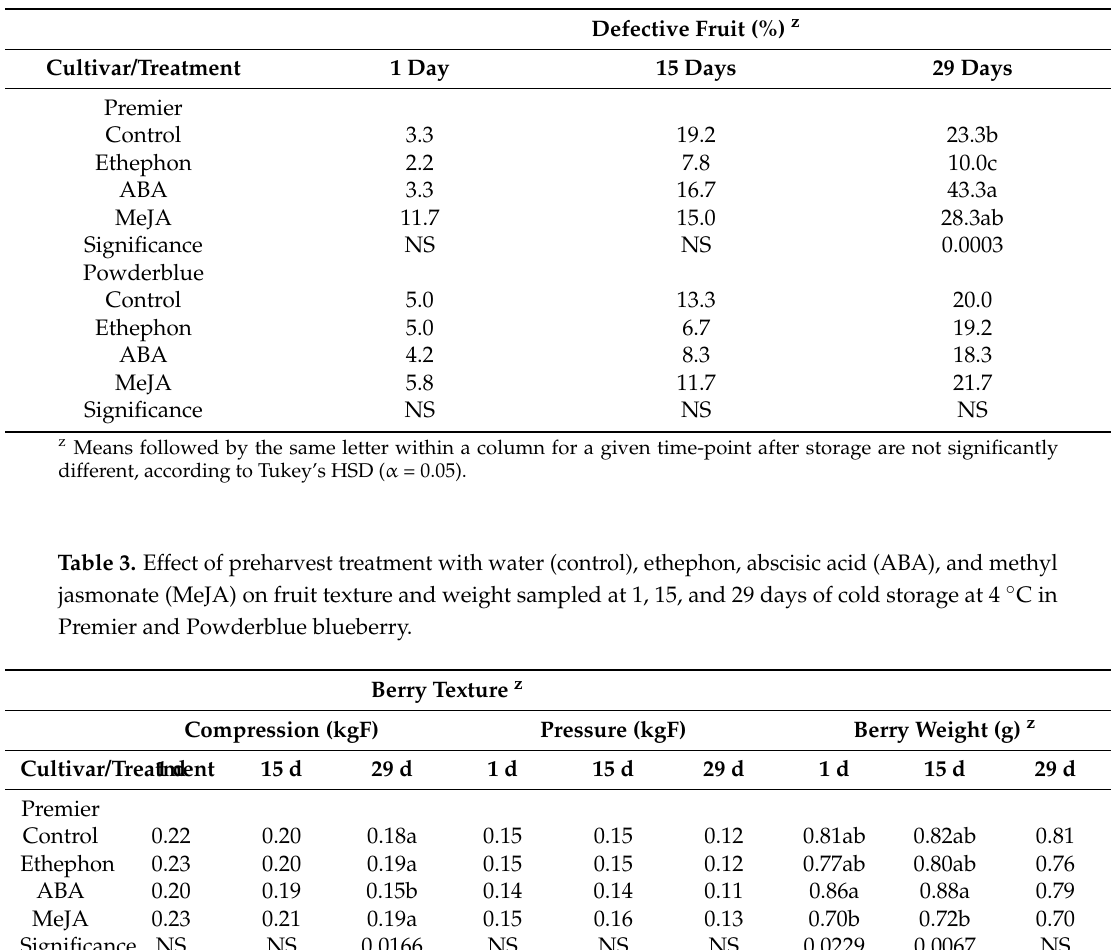
Table 2. Percent defective fruit determined at various times after harvest in Premier and Powderblue blueberry following preharvest treatment with water (control), ethephon, abscisic acid (ABA), and methyl jasmonate (MeJA).